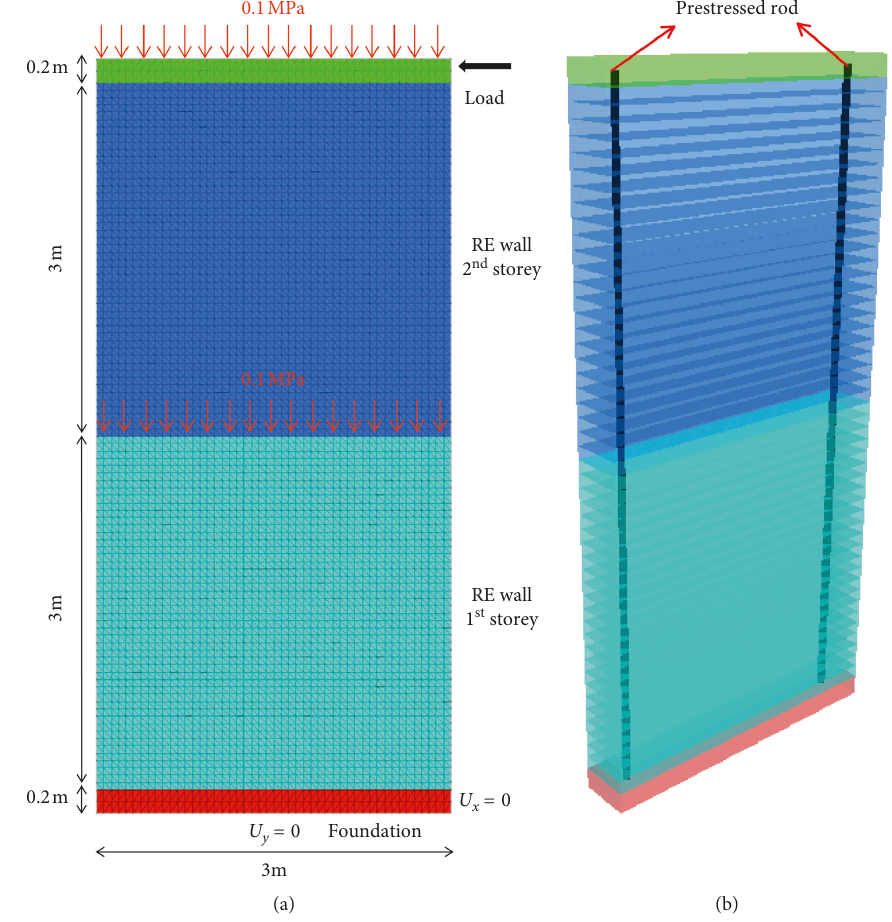
Figure 3: Mesh and boundary conditions of an RE